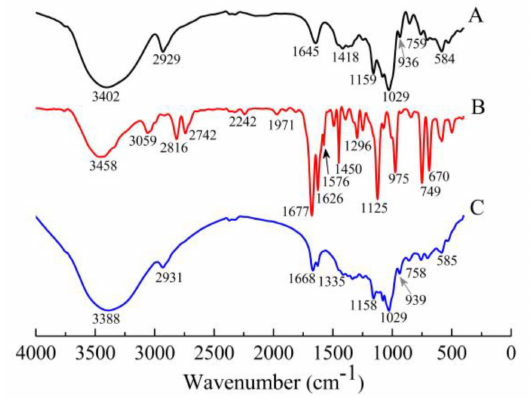
Figure 3. FT-IR spectra of γ -CD ( A ), CL ( B ), γ -CDCL ( C ). FT-IR, Fourier transform infrared; γ -CD, γ -cyclodextrin; CL, cinnamaldehyde; γ -CDCL, cinnamaldehyde/ γ -cyclodextrin inclusion